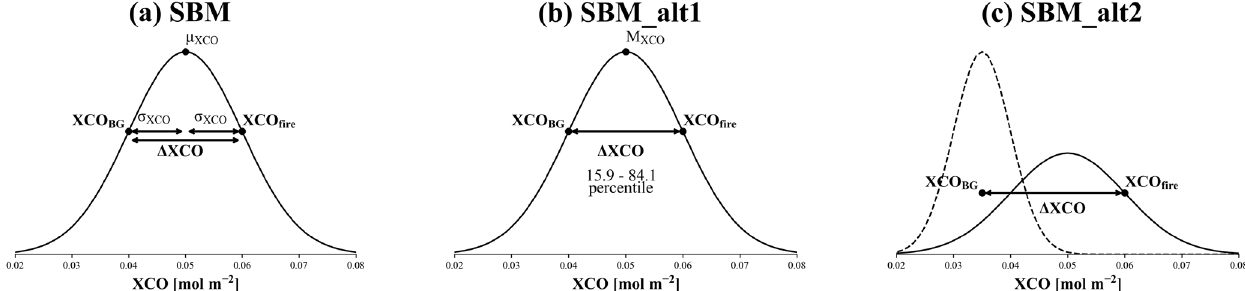
Figure 3. Three types of the statistical bulk method (SBM) are applied to an idealized distribution of X CO samples (molm − 2 ). In panel (a) the standard SBM where (cid:49)X CO ( X CO fire − X CO BG ) is equal to 2 σ X CO around the distribution mean µ X CO . In panel (b) the first alternative SBM (SBM_alt1) where (cid:49)X CO is equal to the difference between the 84.1 percentile rank and the 15.9 percentile rank around the median M X CO . The estimates for (cid:49)X CO from the SBM and SBM_alt1 are only equal if the distributions are perfectly Gaussian. In panel (c) the second alternative SBM (SBM_alt2) where (cid:49)X CO is equal to the difference between X CO fire from the standard SBM and X CO BG derived from the mean concentration of another X CO distribution sampled upwind of the fire region (dashed distribution). The estimates for (cid:49)X CO from the SBM and SBM_alt2 are only equal if X CO BG are the same.